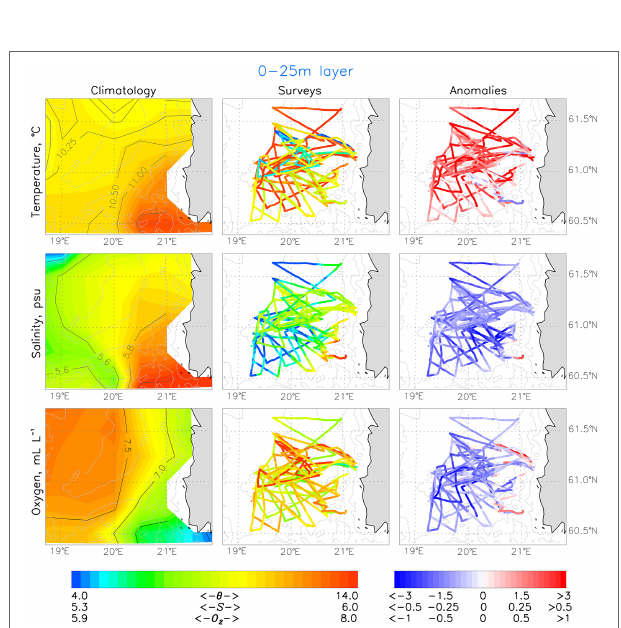
FIGURE 3 | Maps of 0-25m mean water temperature, salinity and dissolved oxygen from (left) July-October climatology, (middle) glider observations, and (right) anomalies computed as differences between glider observations minus climatology taken for the month corresponding to each individual glider observation.